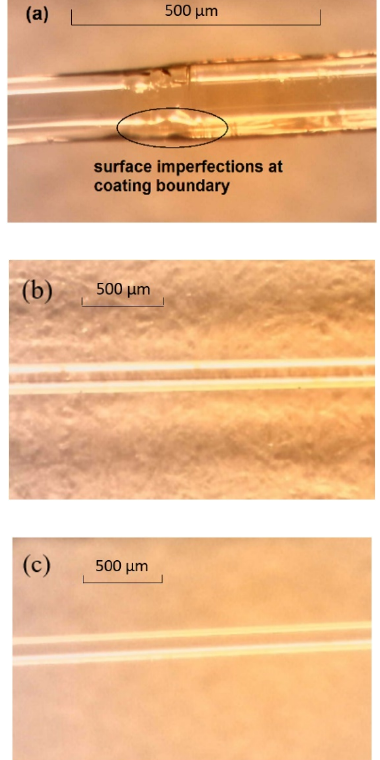
Figure 9. Pre-fatigue microscopic images of fibre surfaces for. ( a ) Stripped and recoated grating. ( b ) Draw tower gratings. ( c ) Trans-jacket gratings. Images (b) and (c) are at lower magnification to show ( b ) Draw tower gratings. ( c ) Trans-jacket gratings. Images ( b ) and ( c ) are at lower magnification to the entire sensing region. show the entire sensing